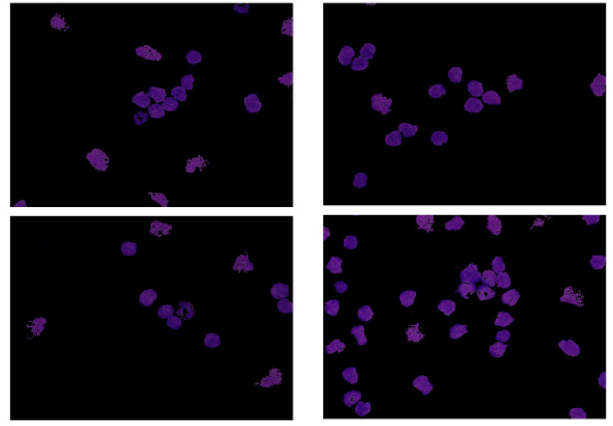
Figure 5. Images after thresholding.